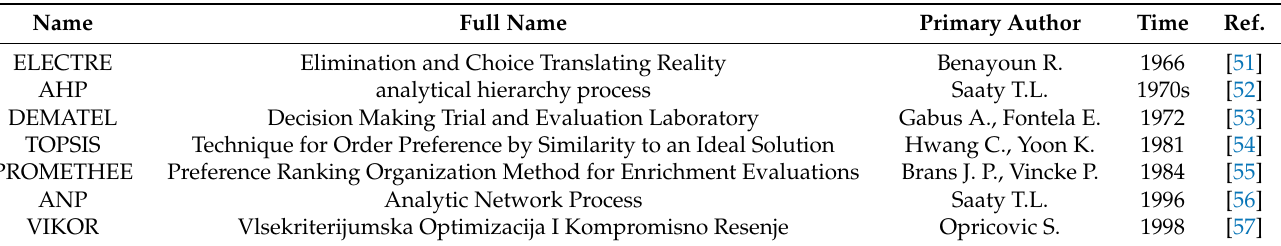
Table 5. Several methods in